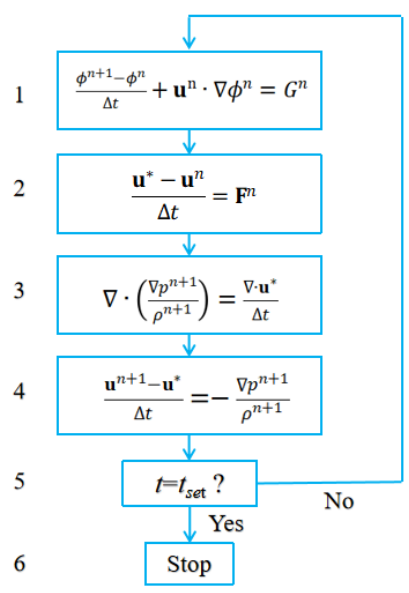
Figure 3. Flow chart of the current algorithm. The superscript n denotes the previous time level, while n+ 1 denotes the current time level. t set represents the time duration for computation. G n stands for the term on the RHS of Equation (1). F n includes all terms in the momentum equation except for the pressure gradient term. u * is the interim velocity.